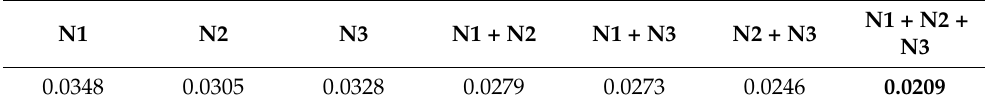
Table 7. The influence of different neighborhood operators on the NSGA-III.